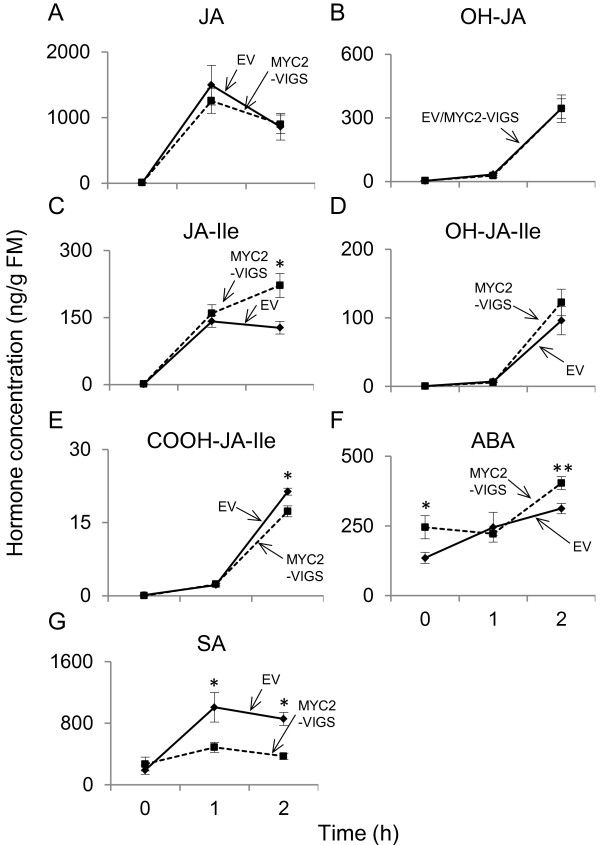
Herbivore-induced accumulation of phytohormones in EV and MYC2-VIGS plants. Fully elongated leaves (n=5) of EV and MYC2-VIGS plants were collected before or 1 h or 2 h after WOS-treatment for phytohormone extraction. Extracts were analyzed on LC-MS3 and the levels (mean ± SE) of JA (A), OH-JA (B), JA-Ile (C), OH-JA-Ile (D), COOH-JA-Ile (E), ABA (F) and SA (G) were determined. Different letters indicate statistically significant differences.